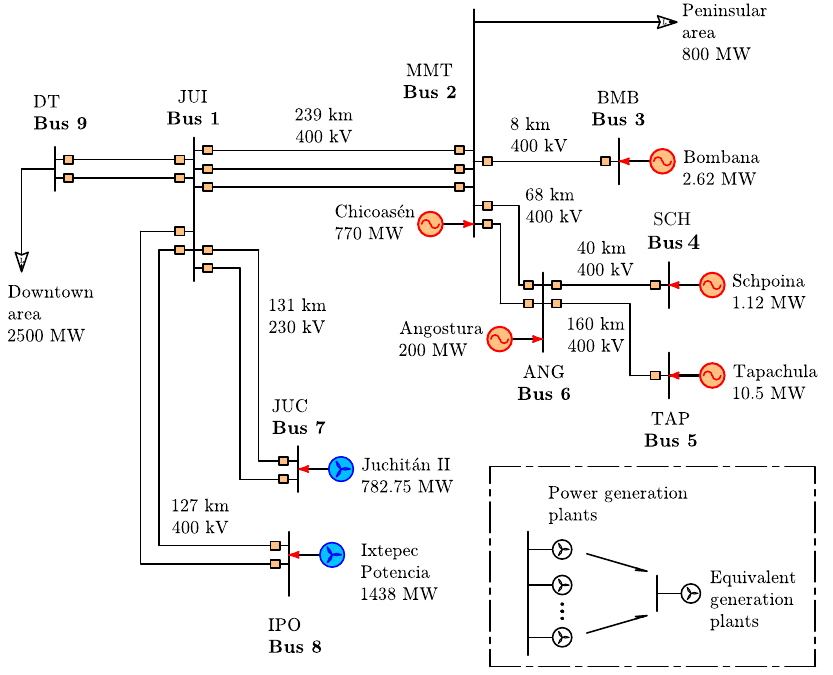
Figure 9. One line simplified diagram of the southeast zone of